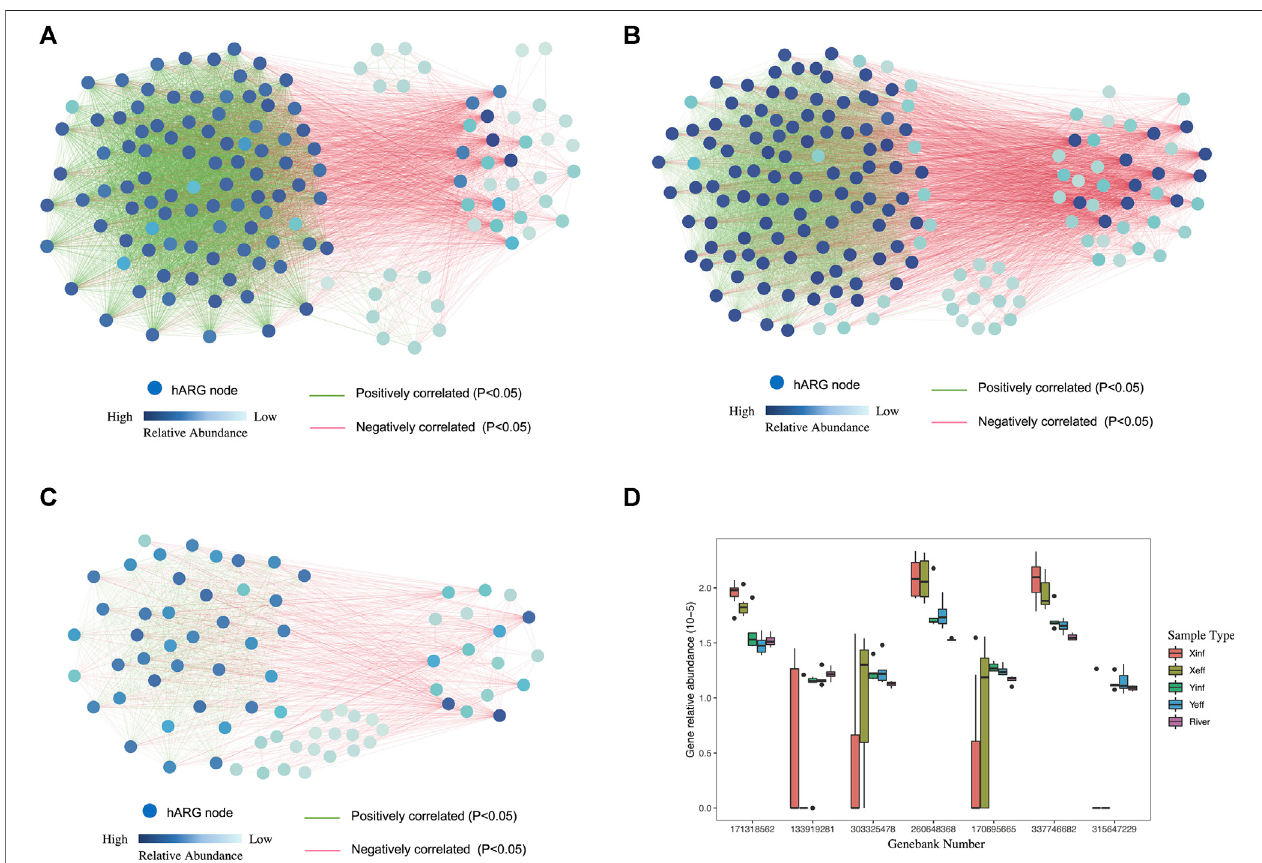
FIGURE 5 | Network analysis of homologous genes of the (A) β _lactamase_A, (B) β _lactamase_C and (C) β _lactamase ARG families in wastewater samples. (D) Relative abundance of representative homologous genes of four β _lactame ARG families in wastewater and river samples.